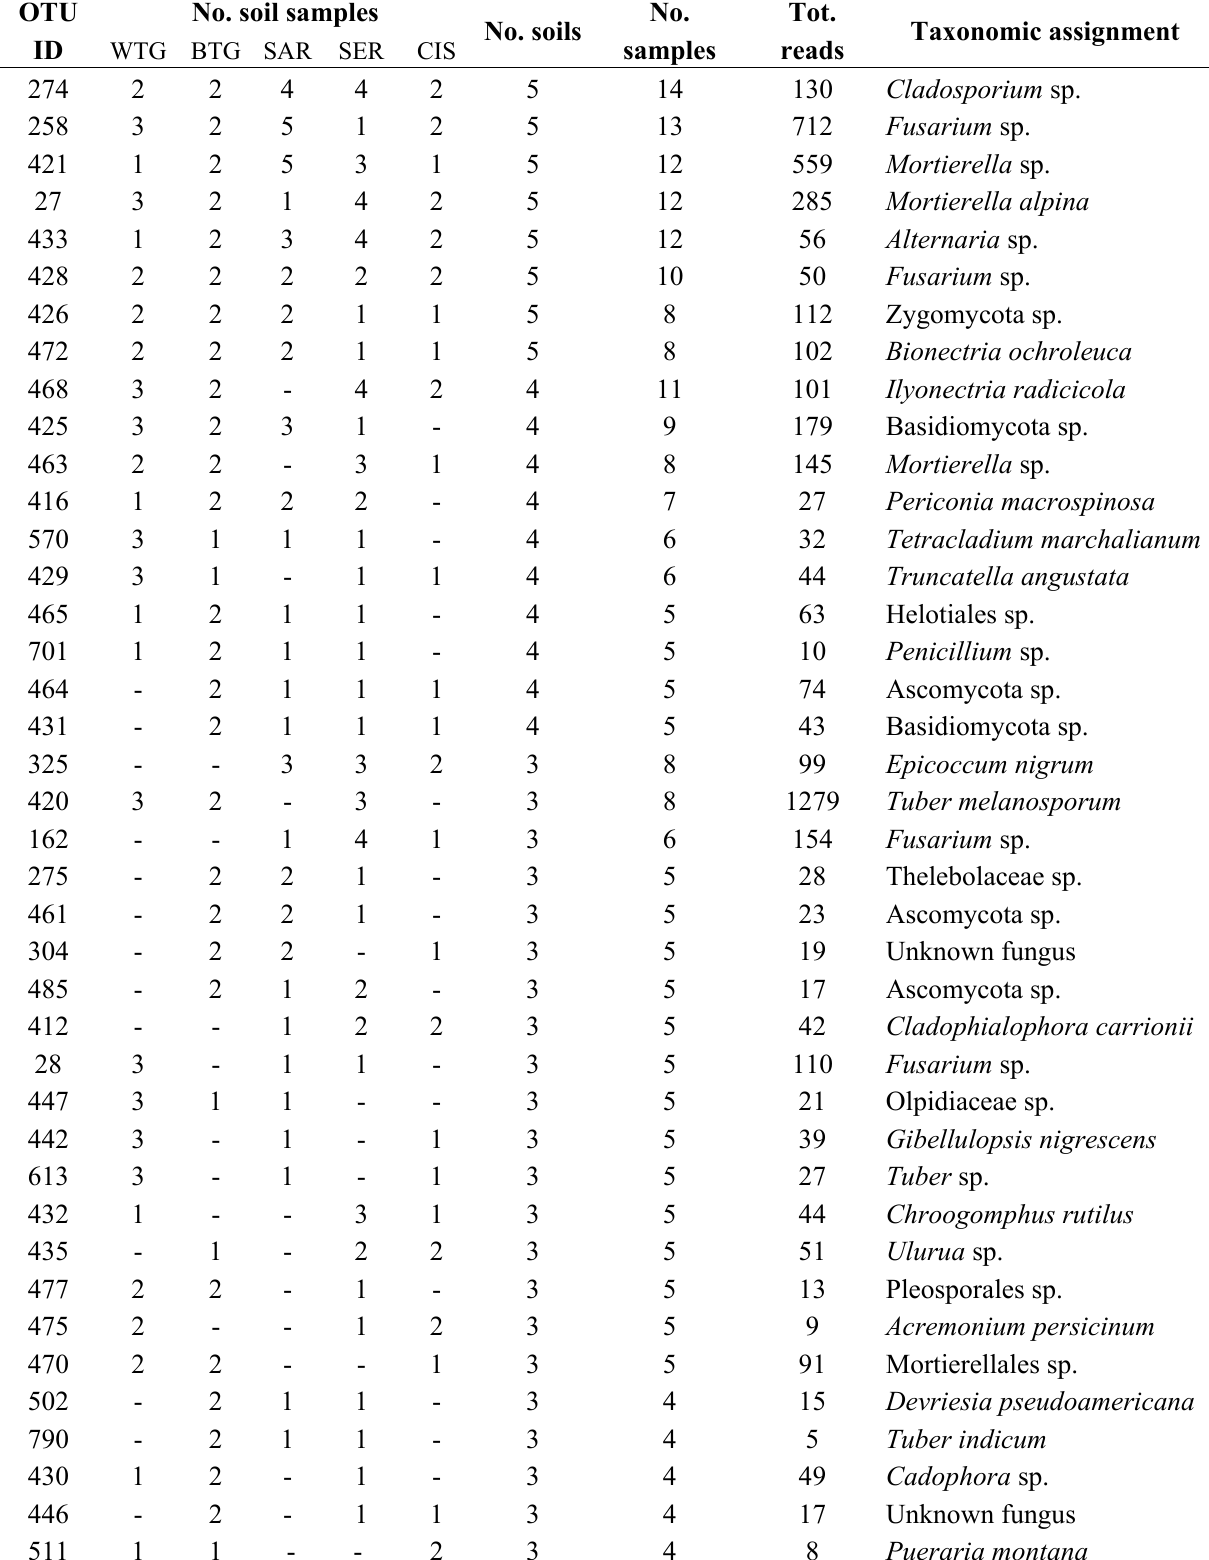
Table 2. ITS1 OTUs occurring in at least three soil sample groups (WTG, BTG, SAR, SER and CIS). Occurrence in the examined soil samples and sample groups, total number of clustered reads and taxonomic assignment are reported for each OTU. OTUs are listed according to decreasing frequency (no. soils and samples they were retrieved